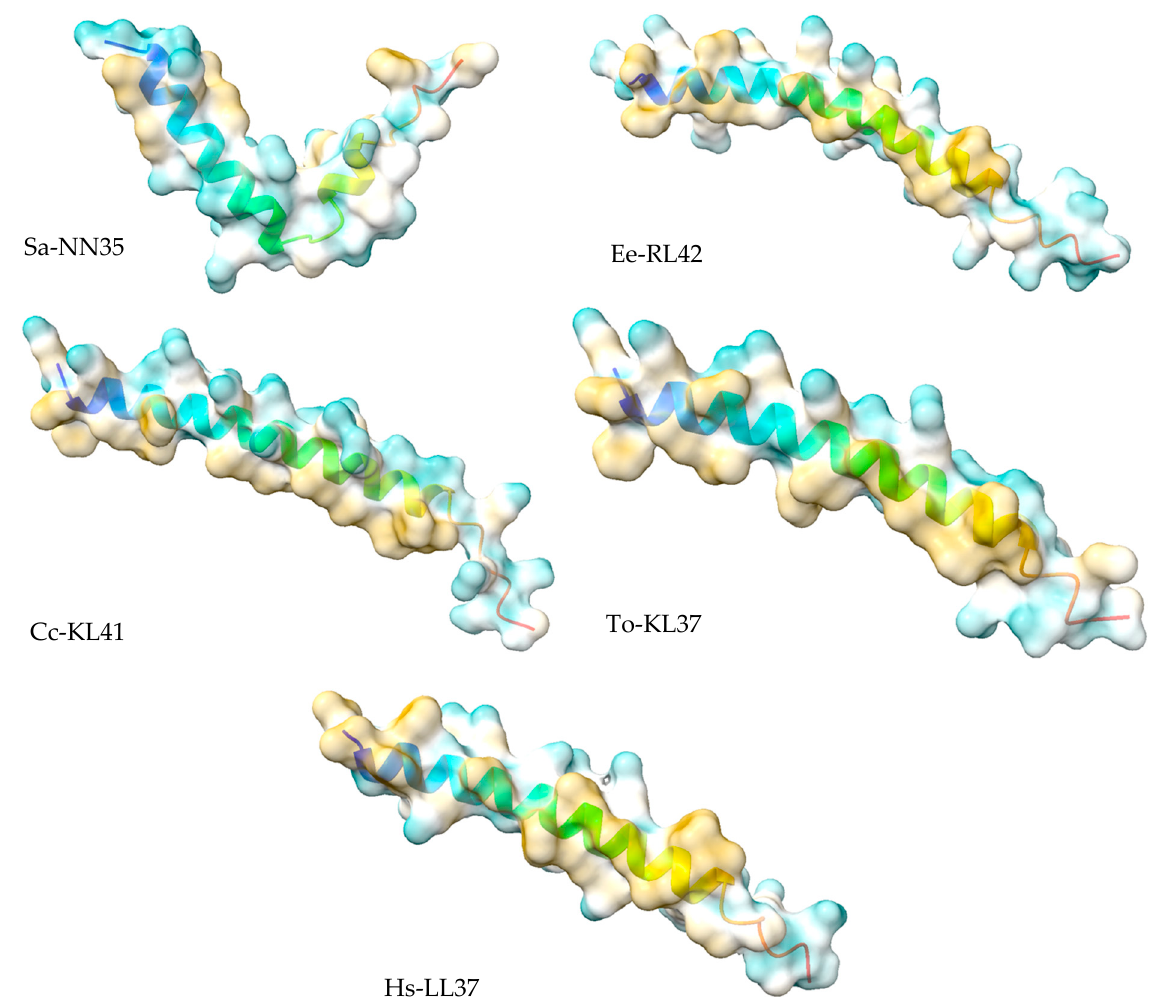
Figure 5. Alphafold structural models of putative antimicrobial peptides from the annotated catheli- cidins of Eulipotyphla order, including Talpa occidentalis . The human cathelicidin peptide LL37 was used as a reference. ChimeraX software was used for the visualization of the structures. The tertiary structure of the peptide is shown in combination with the hydrophobicity as a transparent surface. All models used were those ranked-1 by the Alphafold server. The results are shown with coloring on the molecular surface ranging from dark cyan (most hydrophilic) to white to dark goldenrod (most lipophilic).